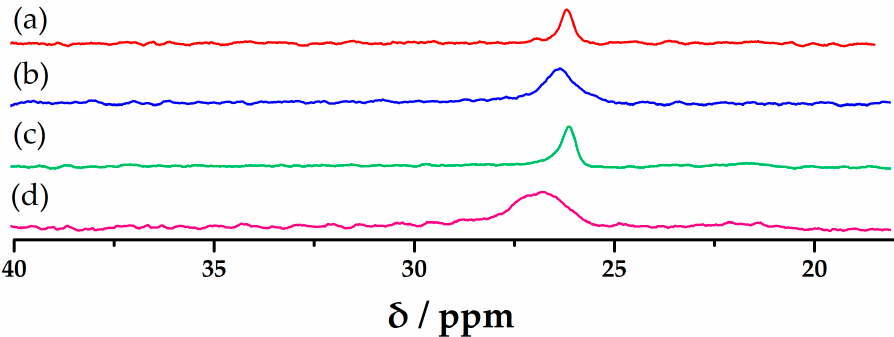
Figure 6. Solution 31 P NMR spectra of 1 after different tests. ( a ) 1 in CH 3 CN after 4 h at 50 °C; ( b ) 1 in CH 3 CN after five days at room temperature; ( c ) 30 mg of 1 after the second catalytic test in optimal conditions; ( d ) 30 mg of 1 after the third catalytic test in optimal conditions; 31 P NMR spectra appears at 0 ppm were referred to 85% H 3 PO 4 .